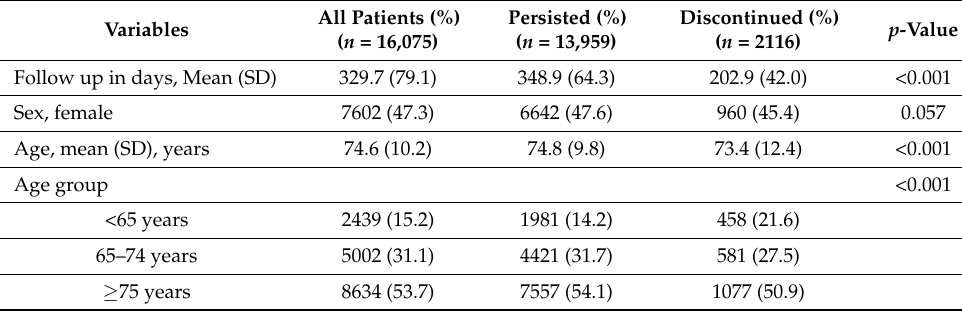
Table 1. Baseline characteristics of study